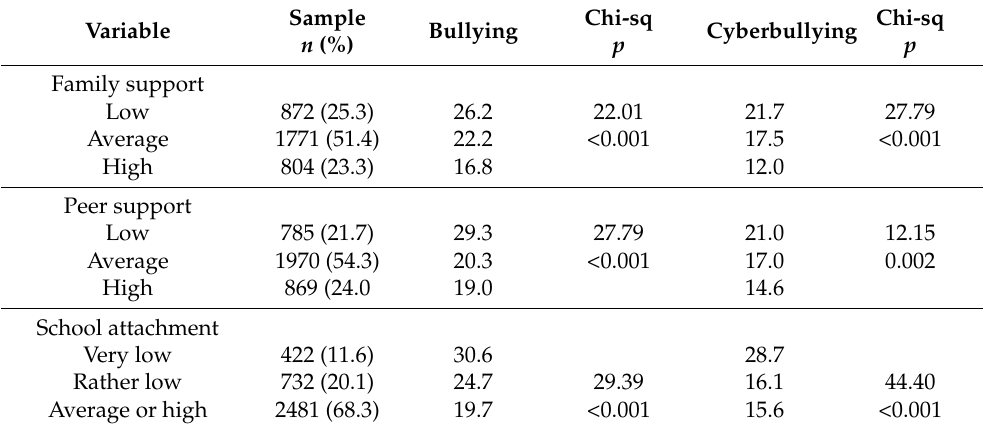
Table 3. Participation in bullying and cyberbullying as perpetrators at least once in the past two months (%) according to social